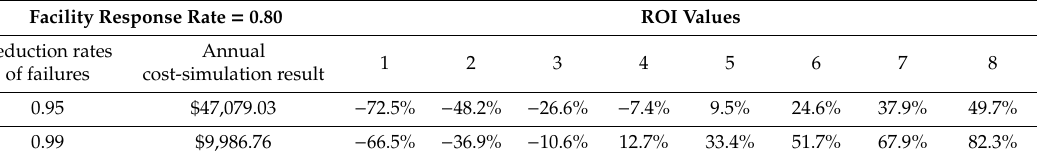
Table 7. Summary of annual cost savings and multi-year ROI for di ff erent rates.